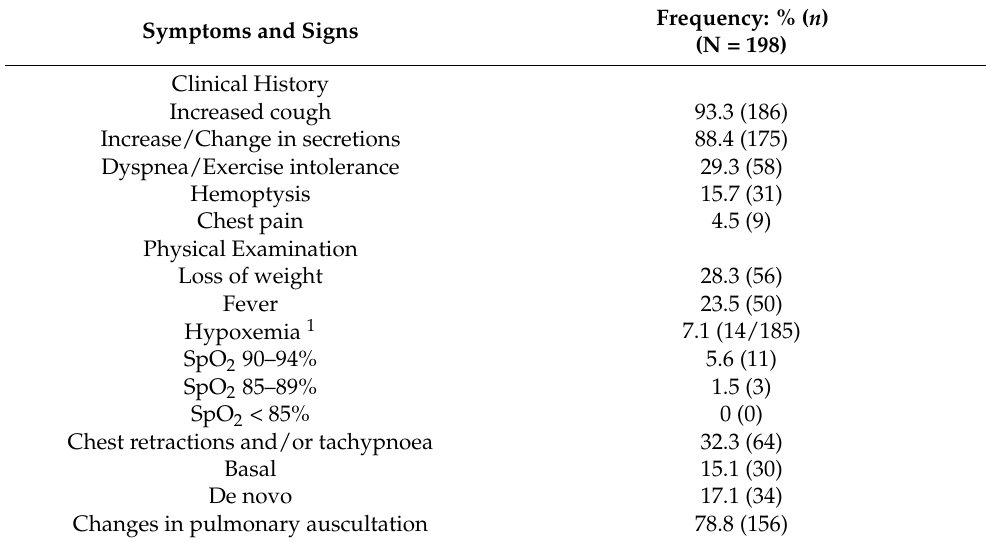
Table 3. Symptoms and